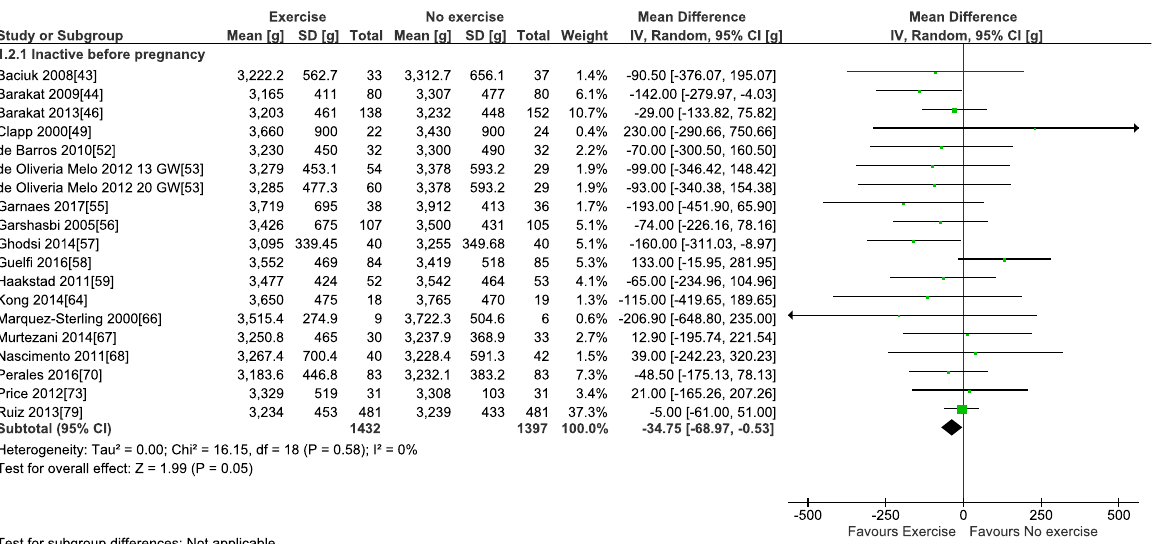
Fig. 3 Forest plot of pooled mean differences for birth weight after exposure to prenatal exercise vs. no exercise; sub-grouping by activity level before pregnancy: active vs.